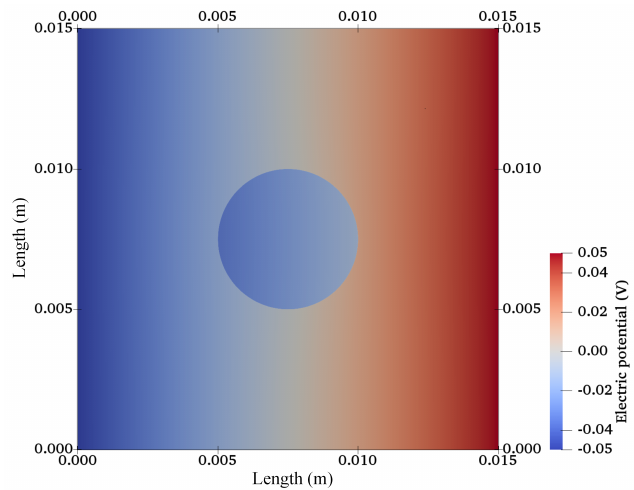
Figure 9. Electric potential distribution for a hydrogel scaffold immersed in